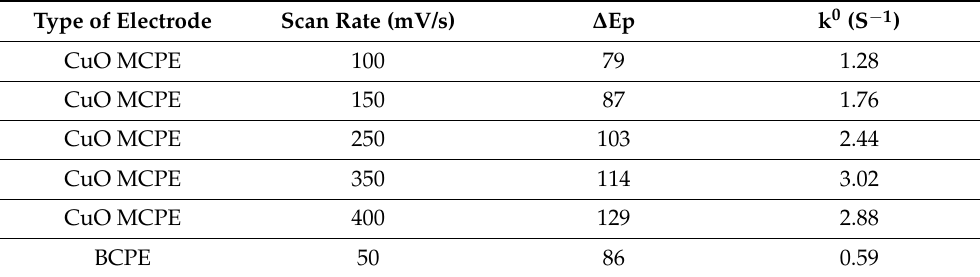
Table 3. The calculated k 0 values for DA at the different experimental scan rates and ∆ Ep respectively using CuO MCPE and BCPE.